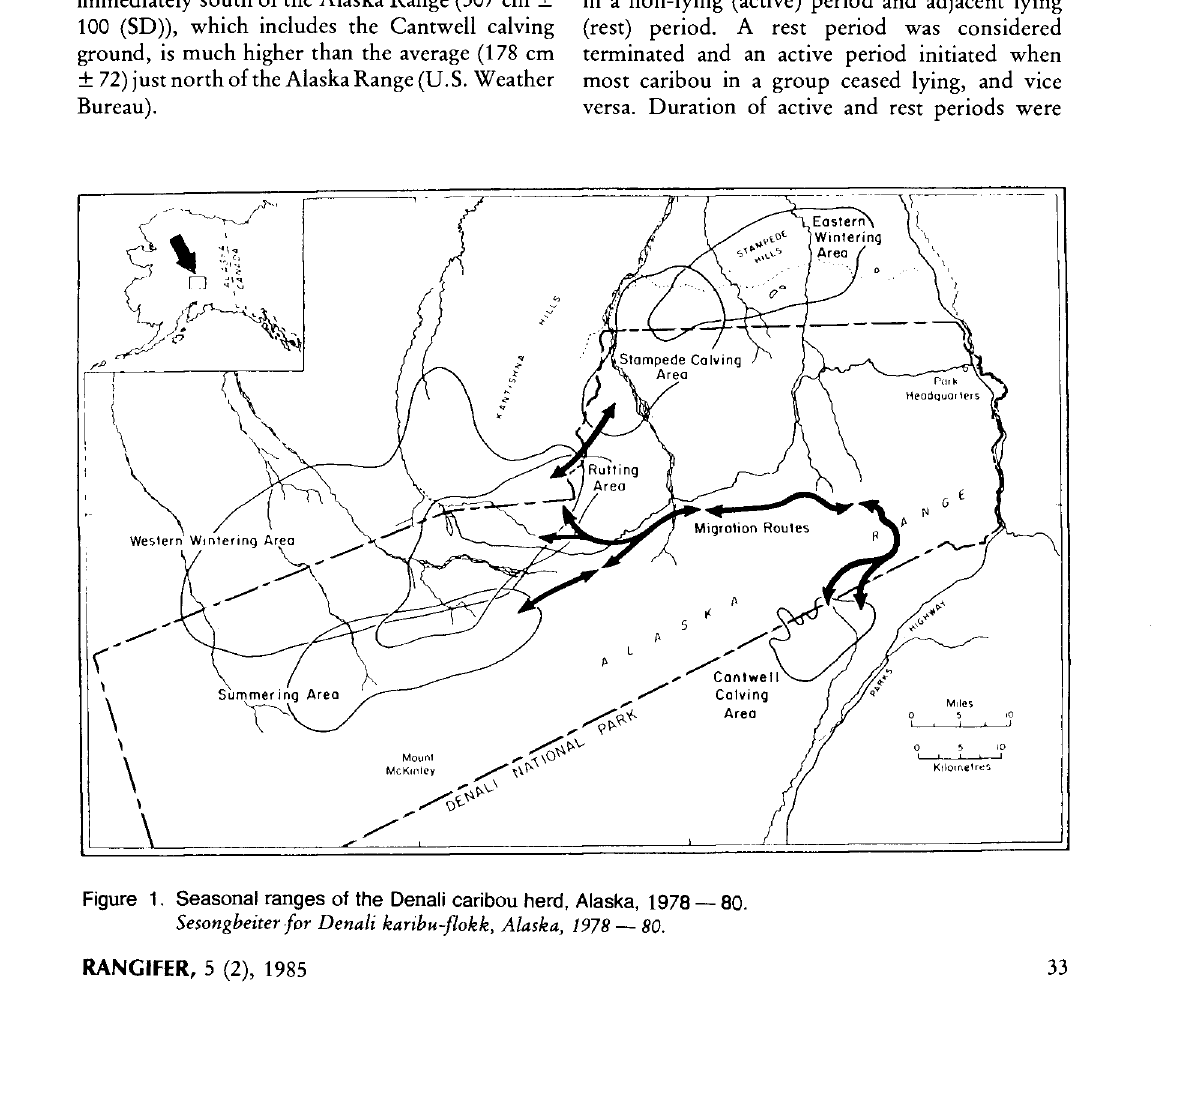
Figure 1. Seasonal ranges of the Denali caribou herd, Alaska, 1 978 —